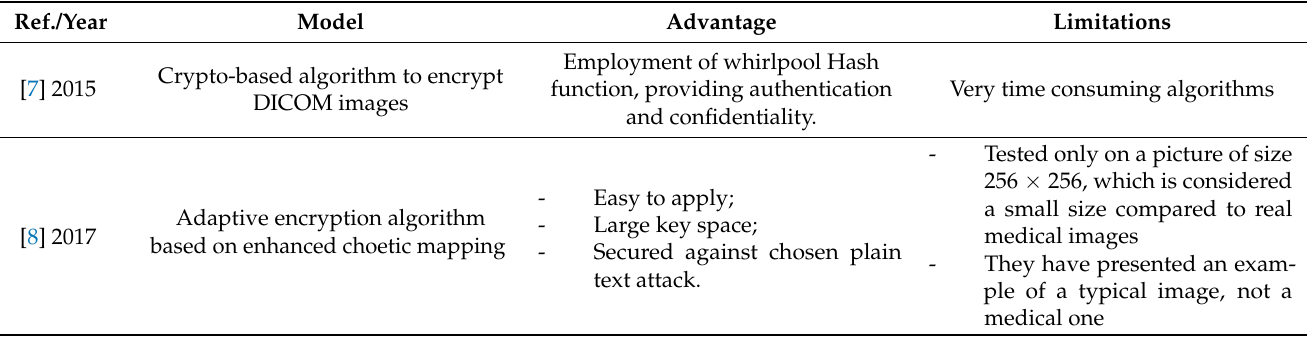
Table 1. Summary of papers reviewed in Related Work